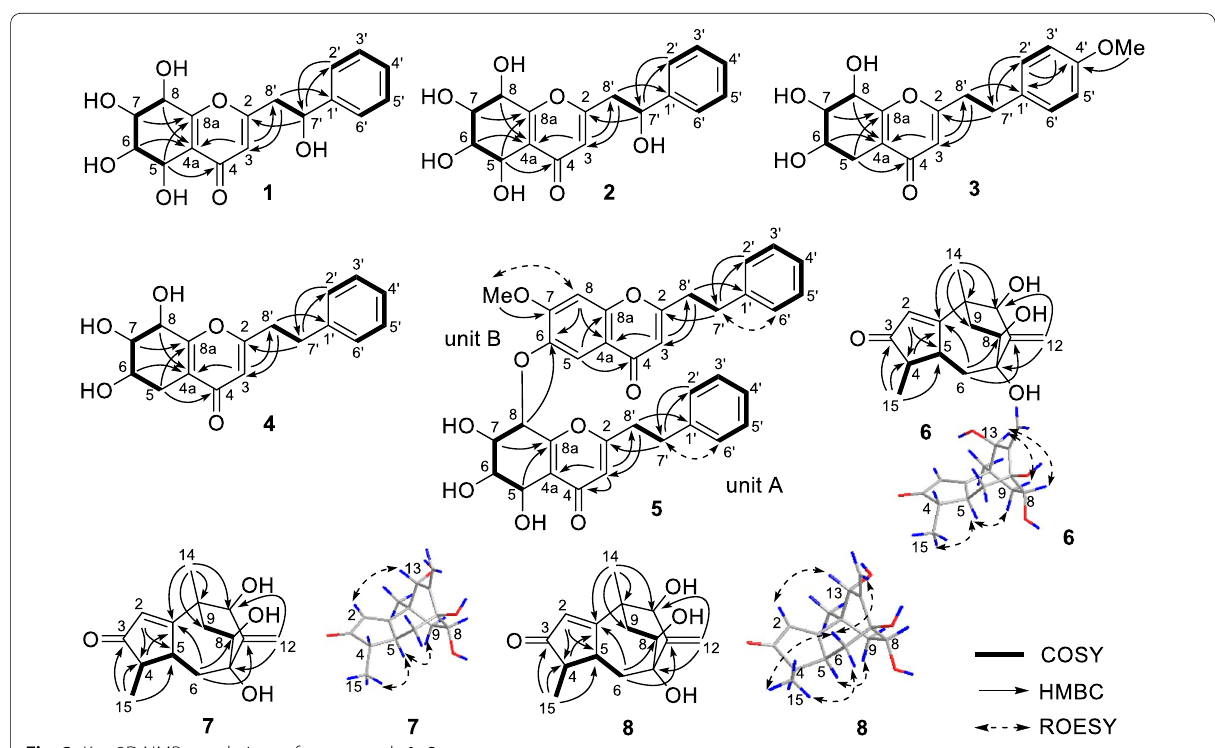
Fig. 2 Key 2D NMR correlations of compounds 1 –